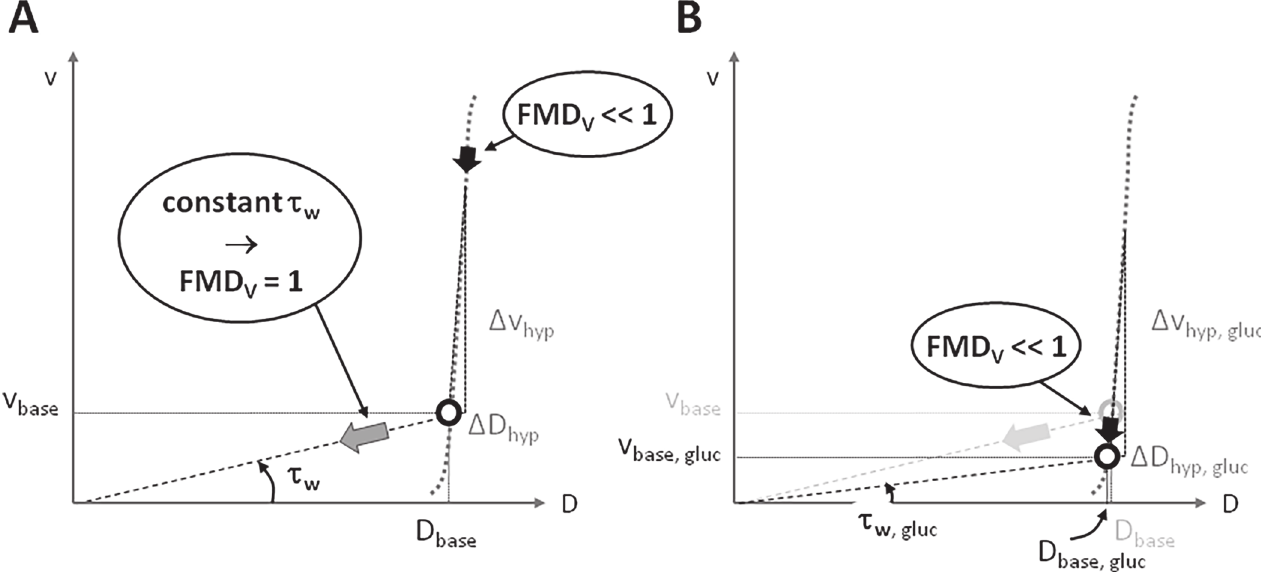
Figure 6. Summary and interpretation of measured changes in local brachial artery flow velocity (v) and diameter (D) after glucose loading. Please note that scales are all conform the relative magnitudes of the effects observed in the study group. Panel A shows the steady-state working point (circle) and hyperemic changes ( Δ ) under the fasting condition. The hyperemic changes are not aligned with the ideal response where wall shear stress ( τ w ~ v/D) would be kept constant perfectly, as indicated by the grey block arrow. FMD V would be equal to 1 in that case. The poor shear stress normalization performance (FMD V << 1; black block arrow) under fasting conditions is corroborated by the shift in the steady-state working point with glucose loading shown in panel B (black block arrow). This analysis indicates that wall shear stress normalization under normal (fasting) conditions is already far from ideal, which does not materially change with glucose